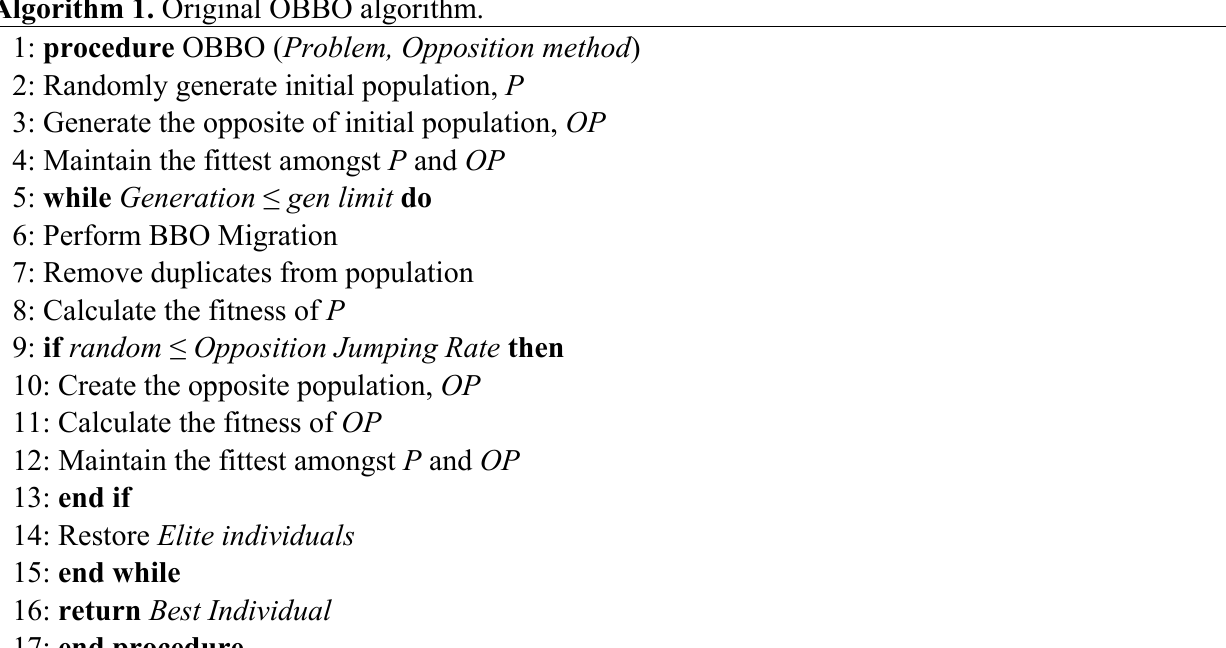
Algorithm 1. Original OBBO